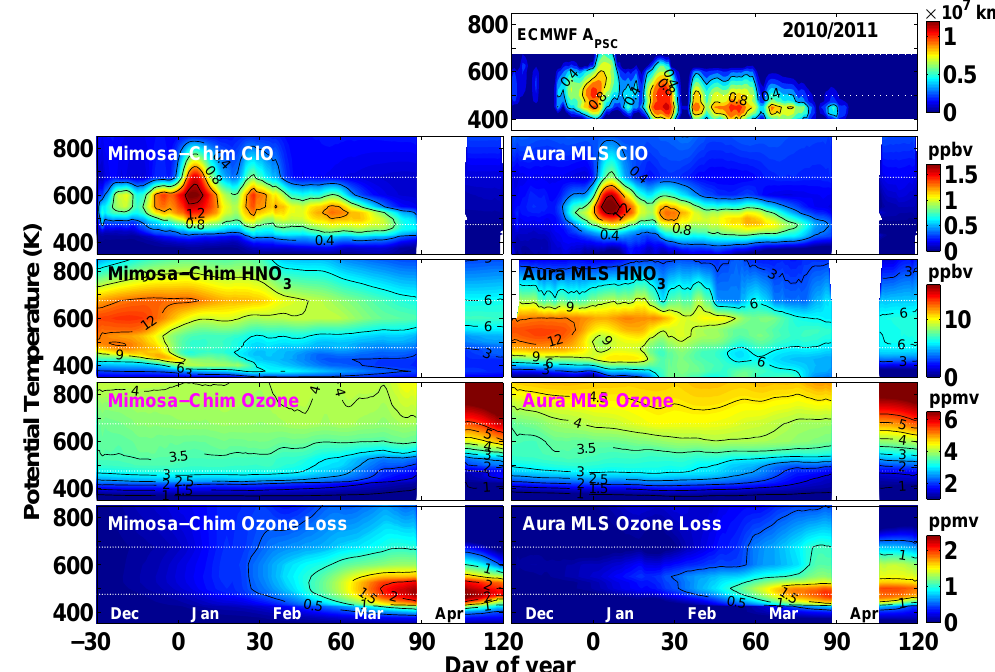
Fig. 5. Temporal evolution of the vertical distribution of ClO (second panel from the top), HNO 3 (third panel from the top), O 3 (fourth panel from the top), and ozone loss (bottom panel) from Mimosa-Chim and Aura MLS for the Arctic winter 2010/2011. The model fields are sampled at the location of MLS observations for each measurement inside the vortex and then averaged for the corresponding day. Both data are smoothed for seven days. The Model and MLS ClO coincident profiles are selected for solar zenith angles < 89 ◦ and local time between 10h and 16h. The MLS ClO profiles are bias corrected (see text). The A PSC computed from the ECMWF operational analyses is also shown (top panel). The white dotted lines represent 475K and 675K. The blue/red colors show relatively low/high values of PSC areas or mixing ratios of ClO, HNO 3 , O 3 , and ozone